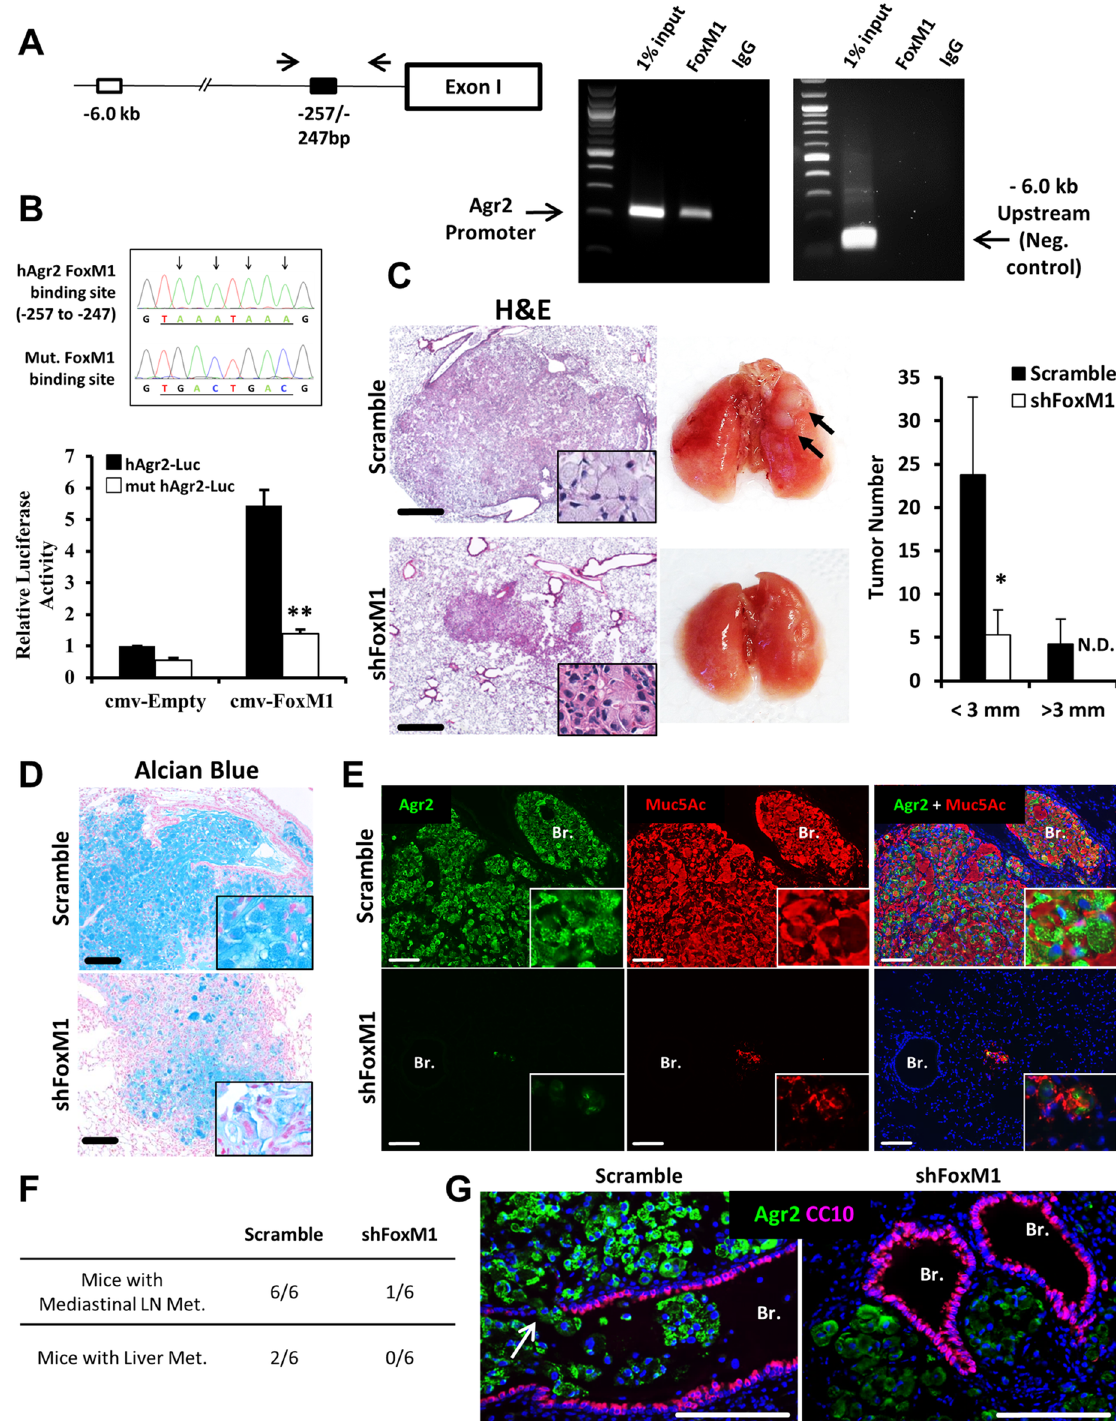
Fig 7. FOXM1 increasestranscription of AGR2 and is required to maintain mucinous phenotype in PIMAs. (A) Schematic of a potentialFOXM1 bindingsite in the AGR2 promoter (left panel). ChIP shows bindingof FOXM1 to the AGR2 promoter in A549 cells (right panel). A549 cells were fixed, lysed, sonicated,and used for immunoprecipitationwith an antibody against FOXM1 or rabbit control IgG. PCR was performed encompassing a predictedFOXM1 bindingsite from -257bpto -247bpof the human AGR2 promoter. DNA regionlocatedat –6.0 kb of Agr2 promoter was used as a negative control. (B) FOXM1 transcriptionally activates AGR2 promoter. Sequence denotes the predicted bindingmotif and the sequencing results